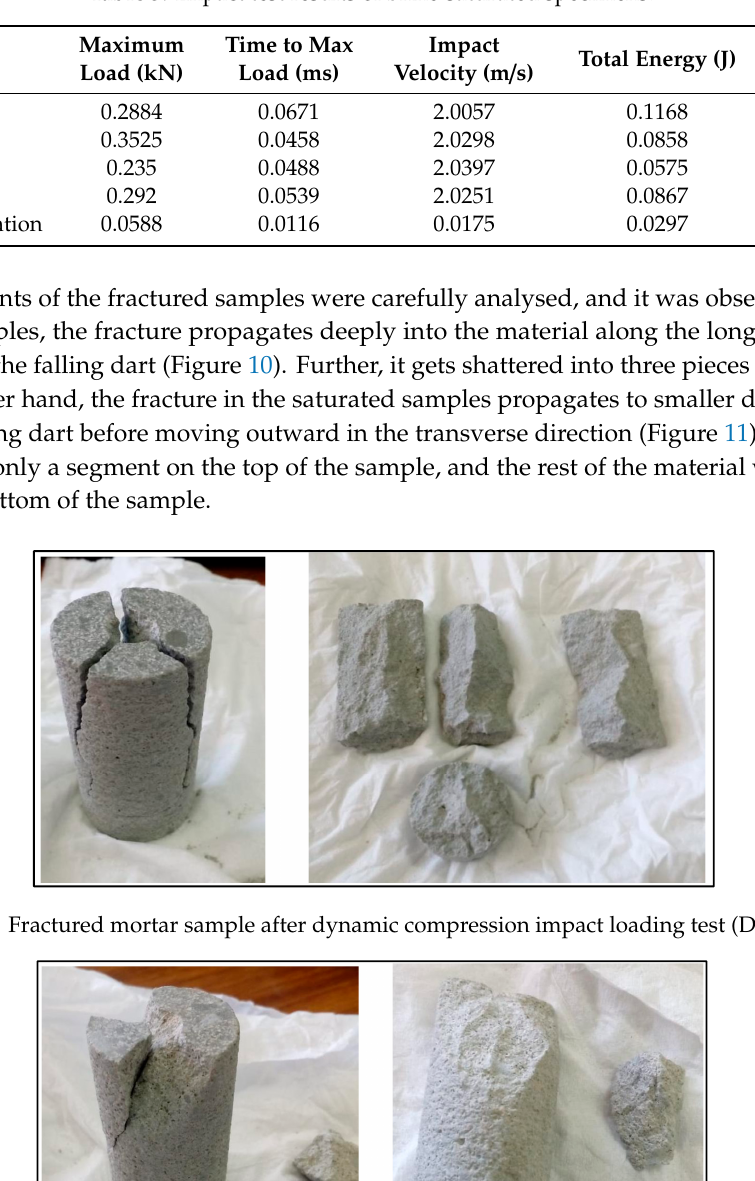
Table 3. Impact test results of brine-saturated specimens.